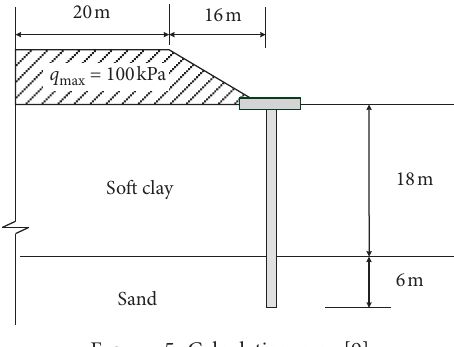
Figure 5: Calculation case